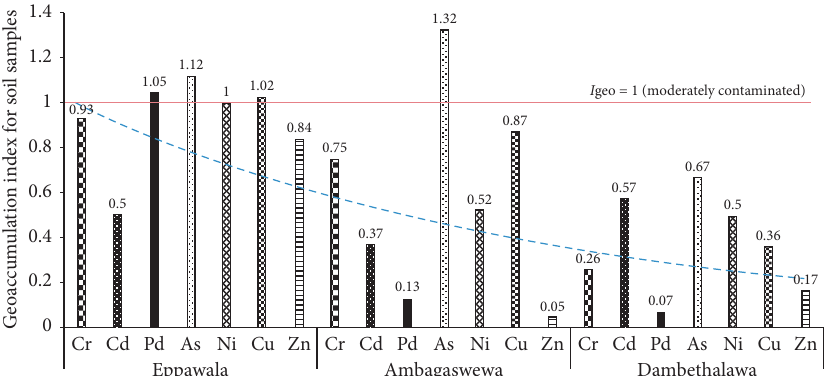
Figure 3: Geoaccumulation index ( I geo ) for heavy metals in paddy cultivated soil of selected GN